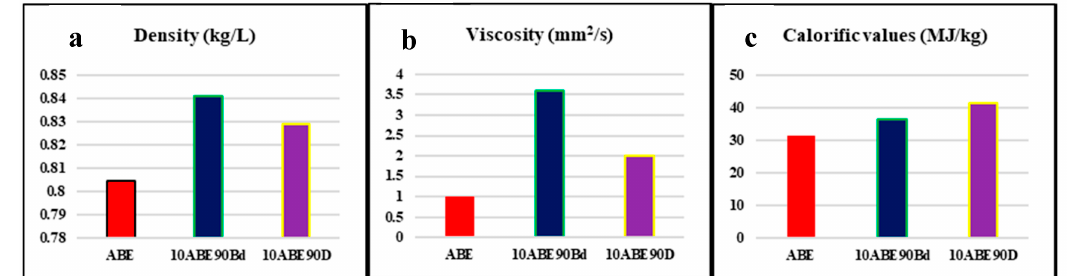
Figure 1. Measured fuel properties. ( a ) Density of test blends; ( b ) Viscosity of test blends; ( c ) Calorifc values of test blends.